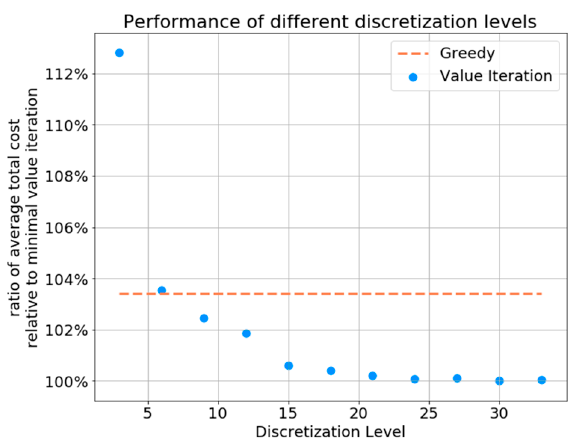
Figure 11. Performance of the value iteration and greedy policies as a function of the discretization level, averaged over 100 i.i.d. Monte Carlo simulations.